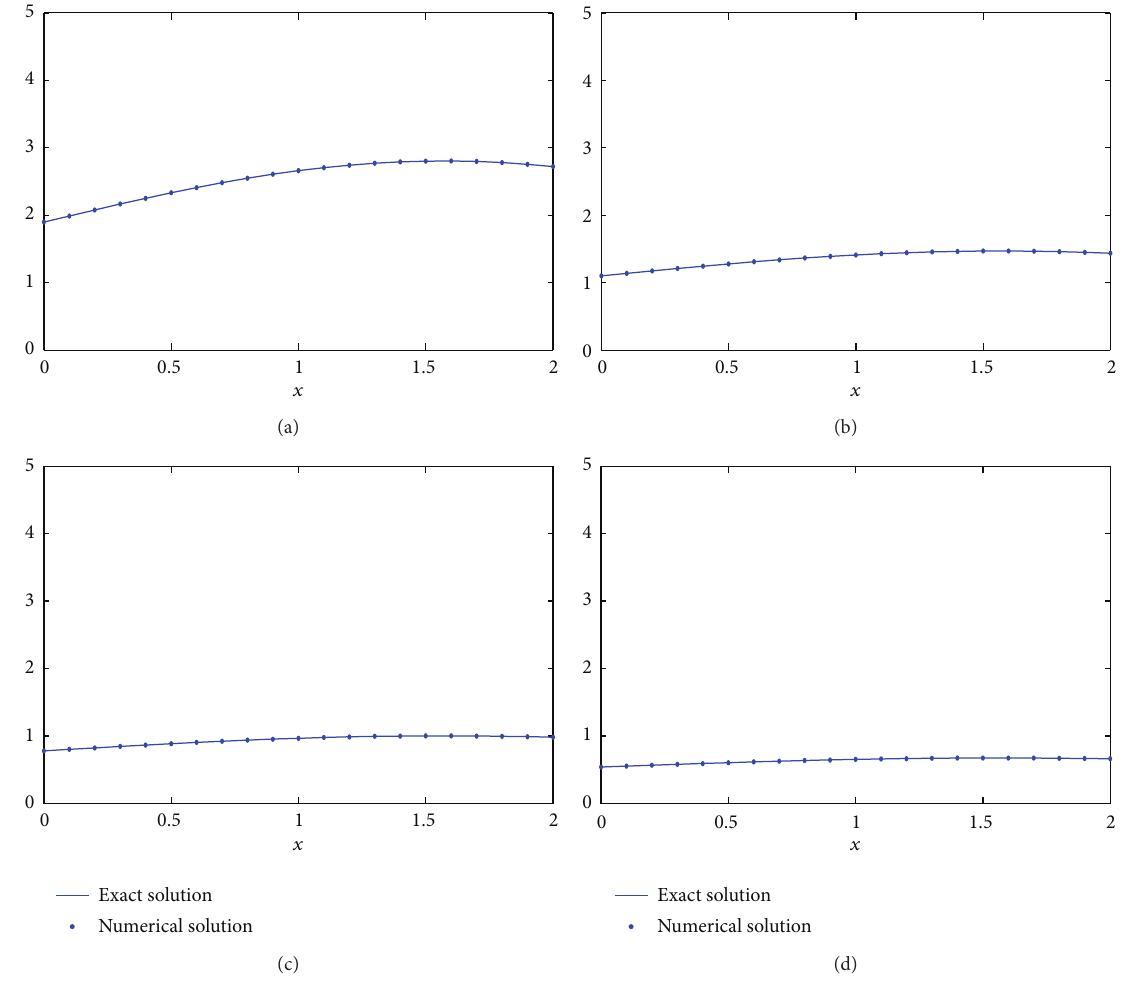
Figure 5: The exact solution 𝑢(𝑥,𝑡) and numerical solution ̂𝑢(𝑥,𝑡) at 𝑡 = 0.1 (a), 1 (b), 1.5 (c), and 2 (d).